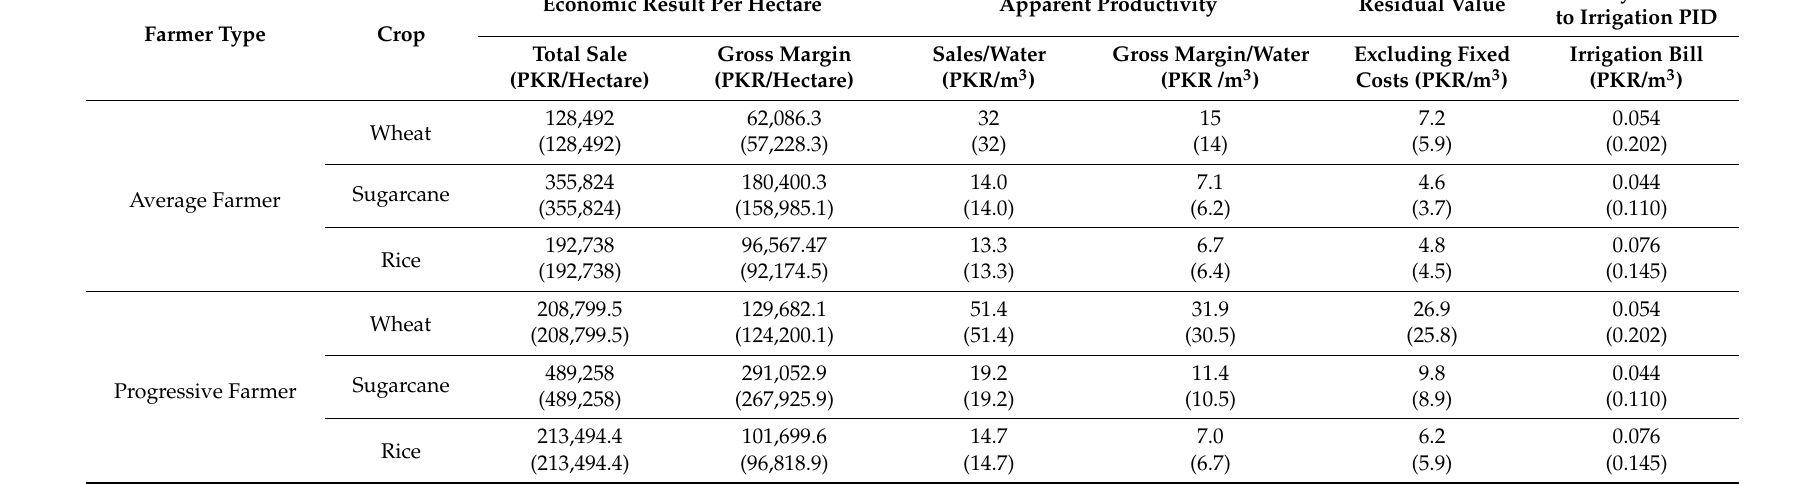
Table 5. Ratios related to Water productivity and residual value of water for 2015–2016 in Rakh Branch Command area. The values in square brackets are for the Ratti